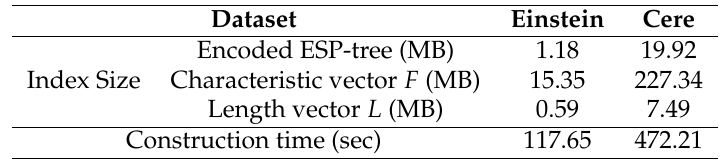
Table 3. Comparison of the index size and construction time.